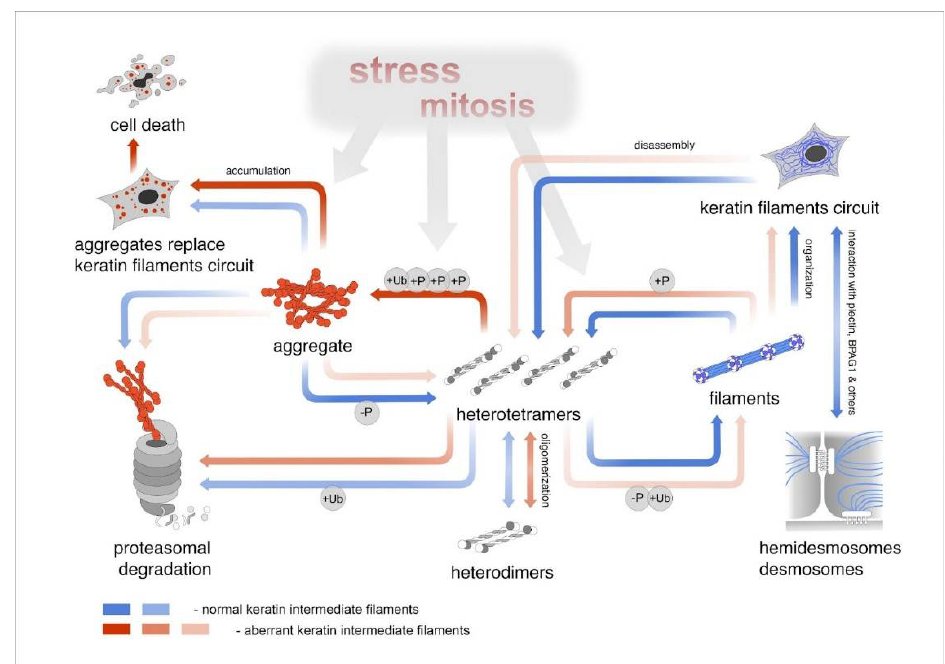
Figure 3 . Keratin turnover and regulation of intracellular trafficking. Blue arrows indicate keratin circuit in healthy conditions; red arrows indicate the balance of mutant forms. The increase and decrease in color intensities reflect the relative strength of a process. Site-specific phosphorylation of keratins plays an important role in epidermal KCs [91]. The phosphorylated and sumoylated state of keratin determines its solubility and protects keratins from ubiquitination and proteasomal degradation [92]. As a result, a total decrease in cell adherence and hemidesmosomal/desmosomal interactions in the case of mutant keratins was demonstrated [93,94]. Aggregation of keratins is observed in EBS cells in severe types of the disease. The basal level of SAPKs (stress-activated protein kinases) is higher in cells derived from severe EBS cells than in healthy cells [95]. Aggregation of nonmutated keratin is connected with mitotic activity in healthy cells.